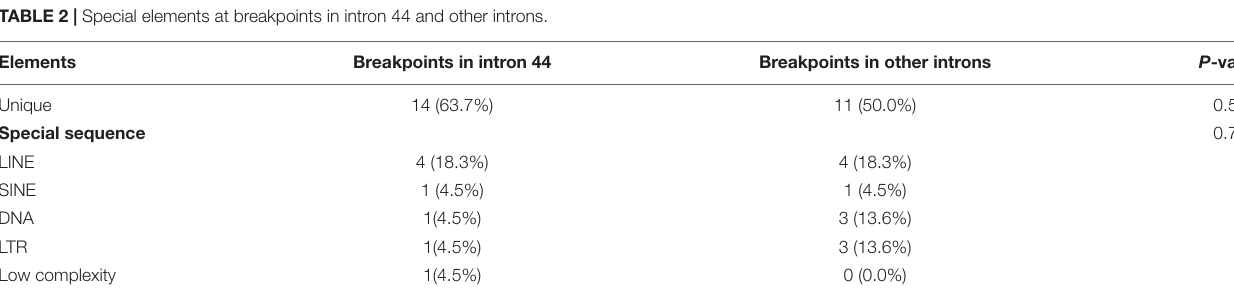
TABLE 2 | Special elements at breakpoints in intron 44 and other